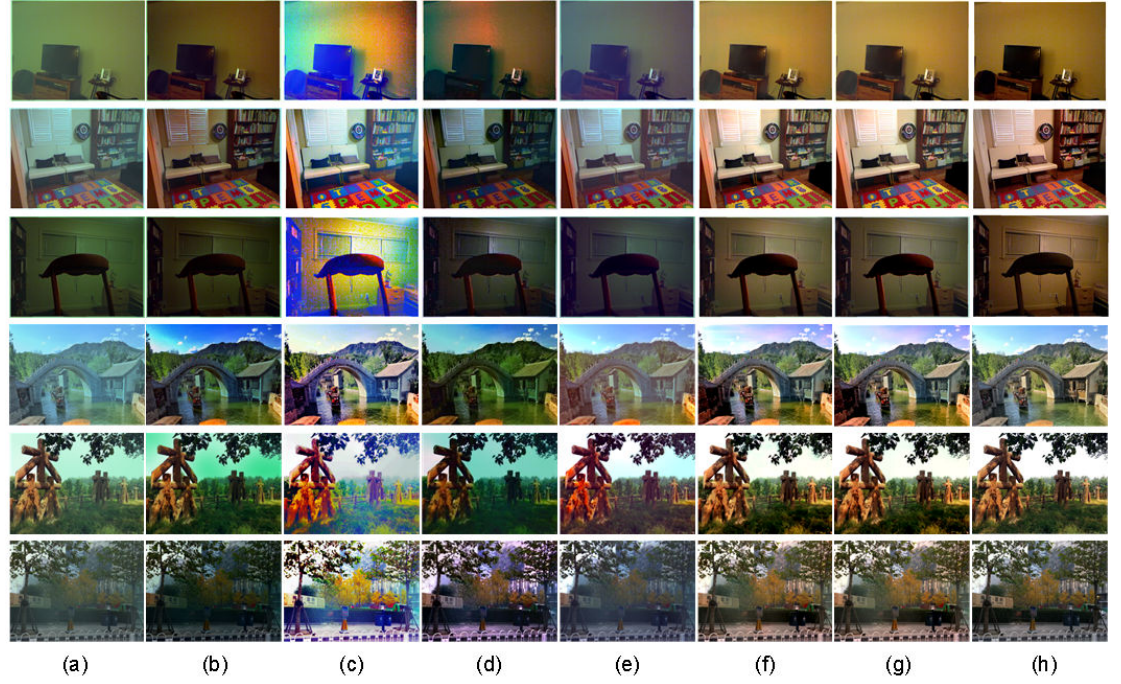
Figure 9. Comparison of different methods on synthetic underwater images. ( a ) the input synthetic underwater images; ( b ) the results of Drews et al. [20]; ( c ) the results of Li et al. [24]; ( d ) the results of Berman et al. [25]; ( e ) the results of Shin et al. [29]; ( f ) our results without the guided filter; ( g ) our results with the guided filter; ( h ) the ground truth clear images.